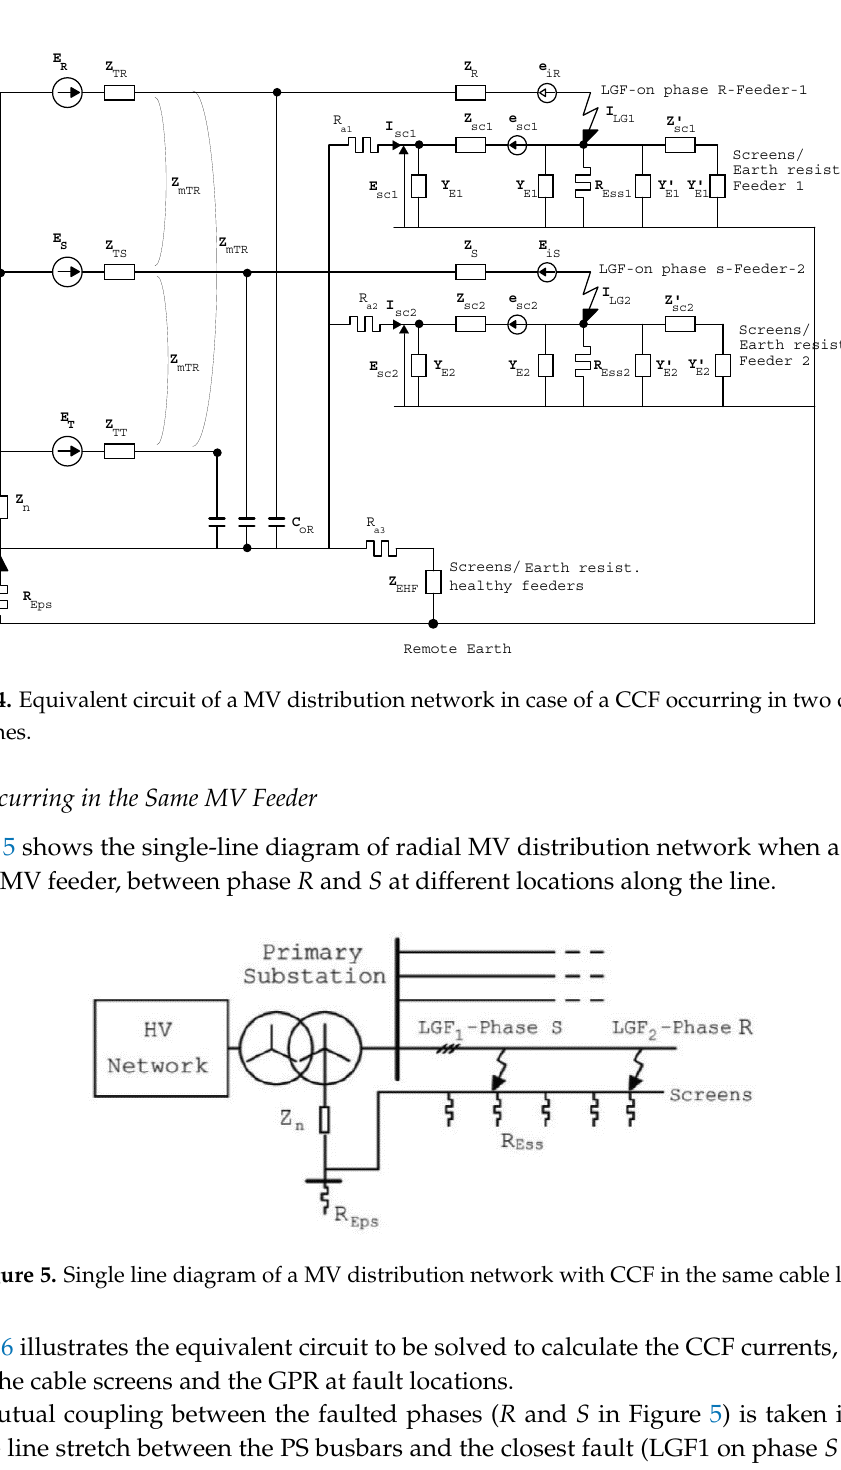
Figure 6. Equivalent circuit of a MV distribution network in case of a CCF occurring in the same cable line.